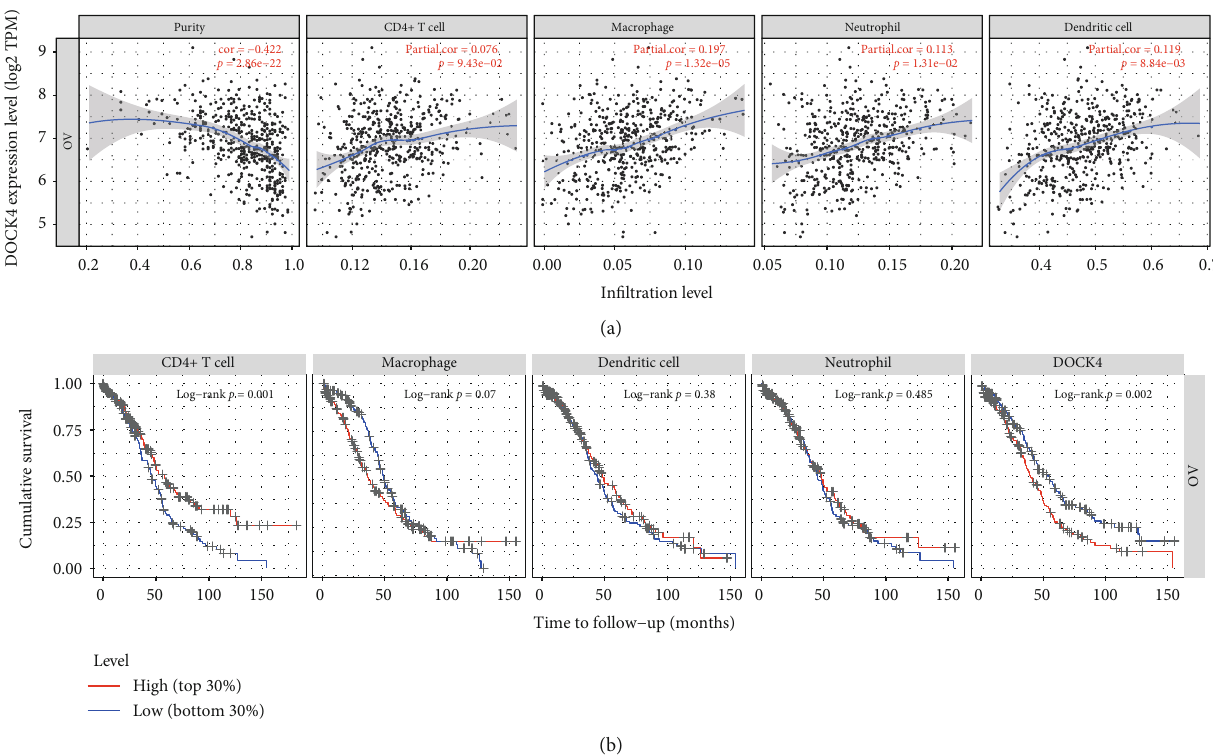
Figure 5: Assessment of the correlation between DOCK4 expression and immune cell in fi ltration. (a) DOCK4 expression is correlated with the level of immune in fi ltration in ovarian cancer. (b) Kaplan-Meier plots of immune in fi ltration and DOCK4 expression levels in ovarian cancer. Table 1: Multivariate analysis associated with overall survival in ovarian cancer patients ( n = 547 ).